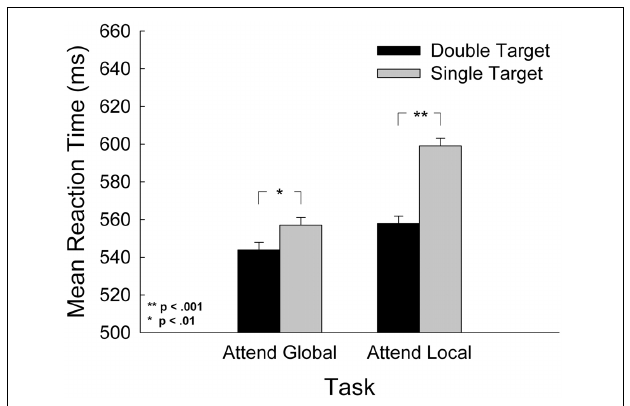
FIGURE 3 | Mean response time as a function of task and of target level, where double target contained a target at both the global and local levels, and single targets contained a target at the attended level only. Error bars represent standard error of the